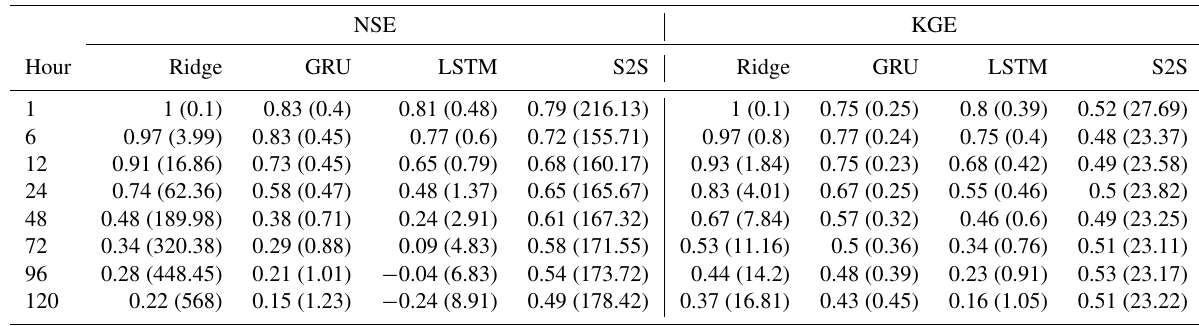
Figure 6. The median NSE and KGE among 125 watersheds using one regional model at the prediction of the next 1–120h. Table 5. The median (standard deviation) NSE and KGE among 125 watersheds at the prediction hour 1, 6, 12, 24, 48, 72, 96, and 120 using one regional model.